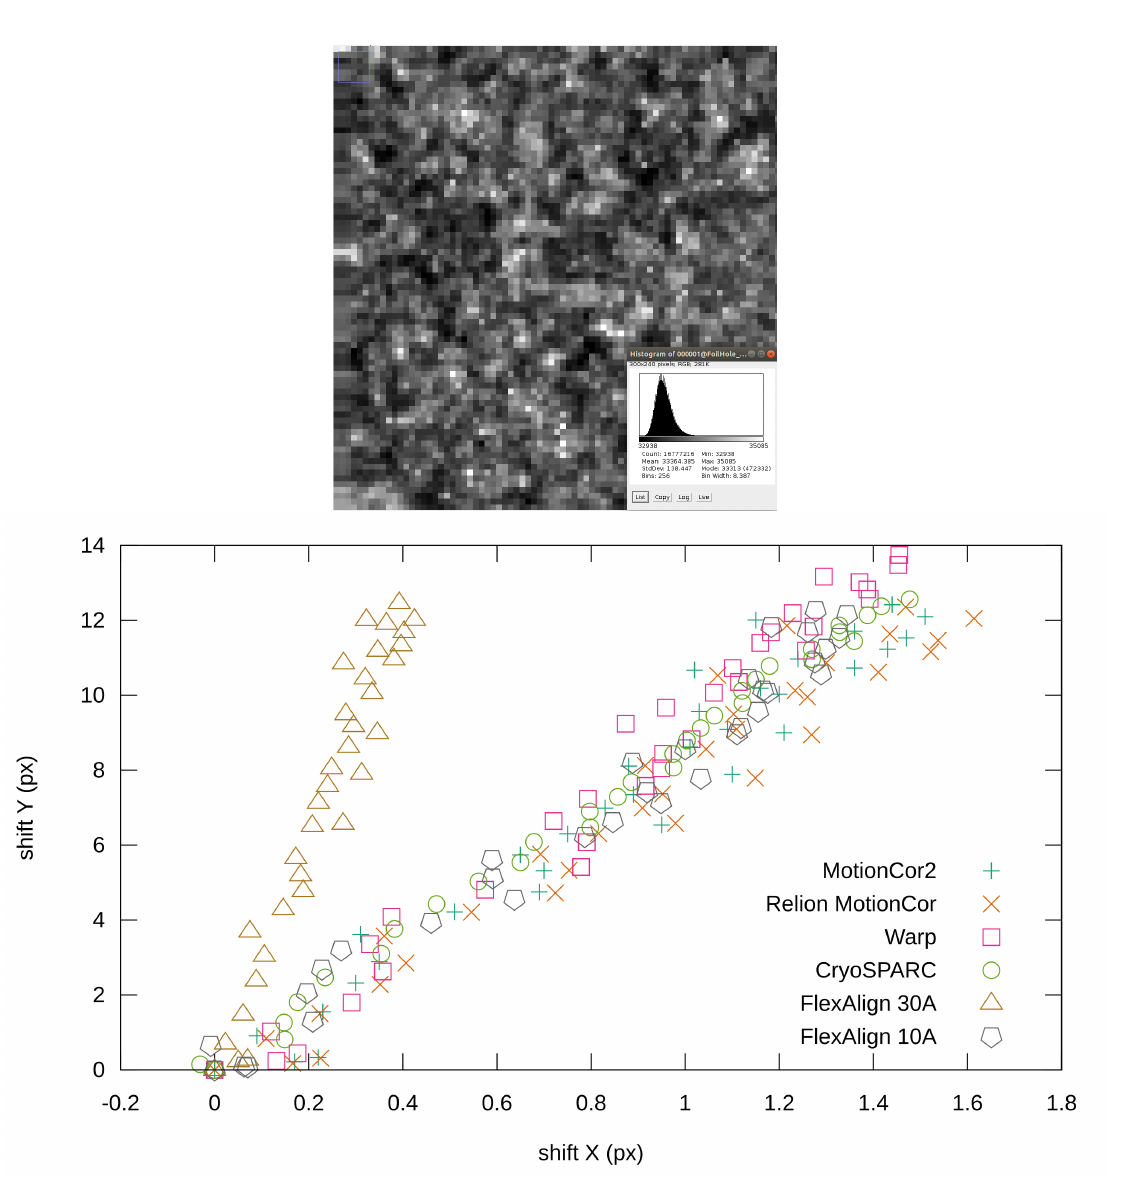
Figure 11. Details of the frame from the EMPIAR 10314 (normalized) with histogram (before normalization) ( top ), reported global shifts by different programs ( bottom